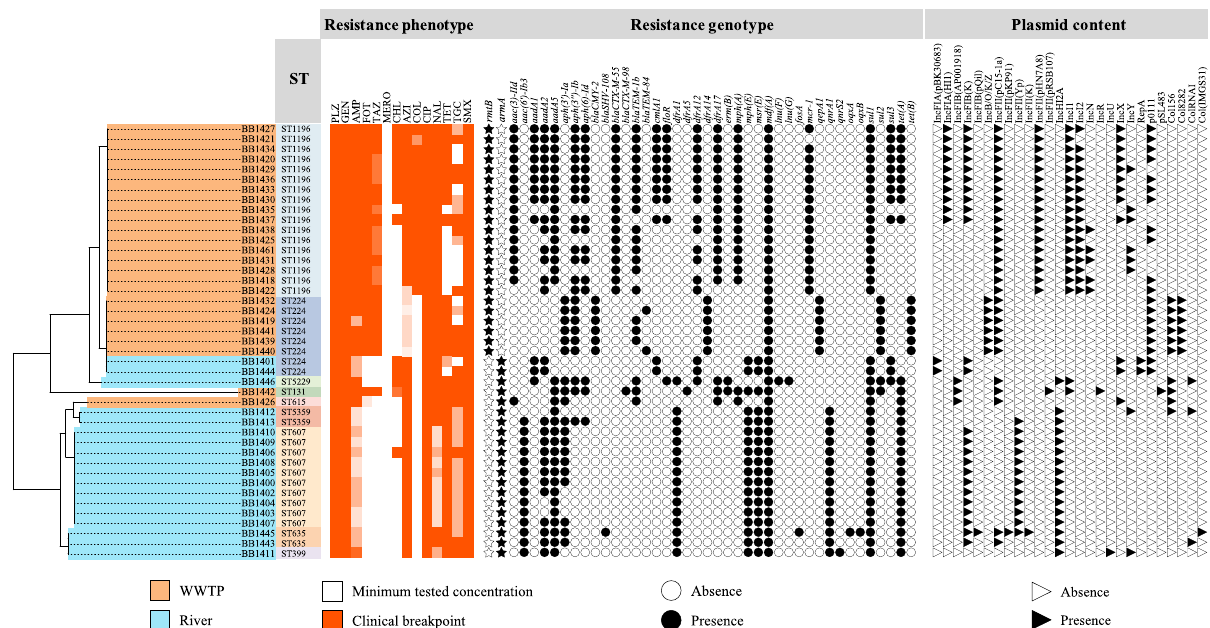
Fig. 2 Sequenced E. coli data. The source of the isolates is speci fi ed by different colors in the genomic SNP-tree branches, as well as the related sequence type. Level of resistance to all tested antibiotics is shown in a gradient of colors: PLZ (plazomicin), GEN (gentamicin), AMP (ampicillin), FOT (cefotaxime), TAZ (ceftazidime), MERO (meropenem), CHL (chloramphenicol), TMP (trimethoprim), AZI (azithromycin), COL (colistin), CIP (cipro fl oxacin), NAL (nalidixic acid), TET (tetracycline), TGC (tigecycline), and SMX (sulfamethoxazole). The presence and absence of antibiotic resistance genes and plasmid incompatibility groups are indicated by circle and triangle symbols, respectively. The presence and absence of speci fi c 16S-RMTase genes are indicated by star